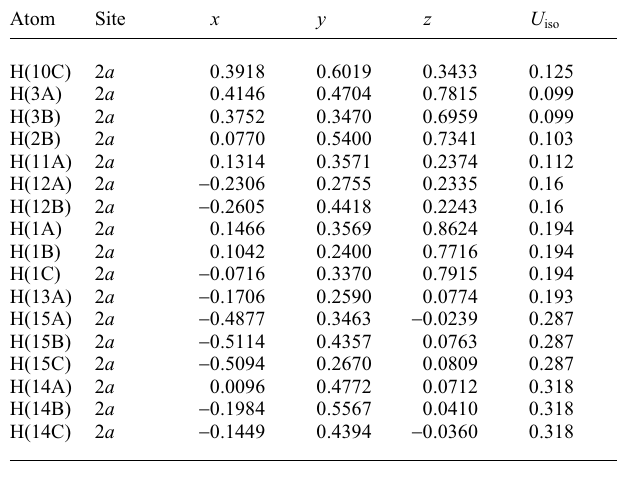
Table 3. Atomic coordinates and displacement parameters (in Å 2 )